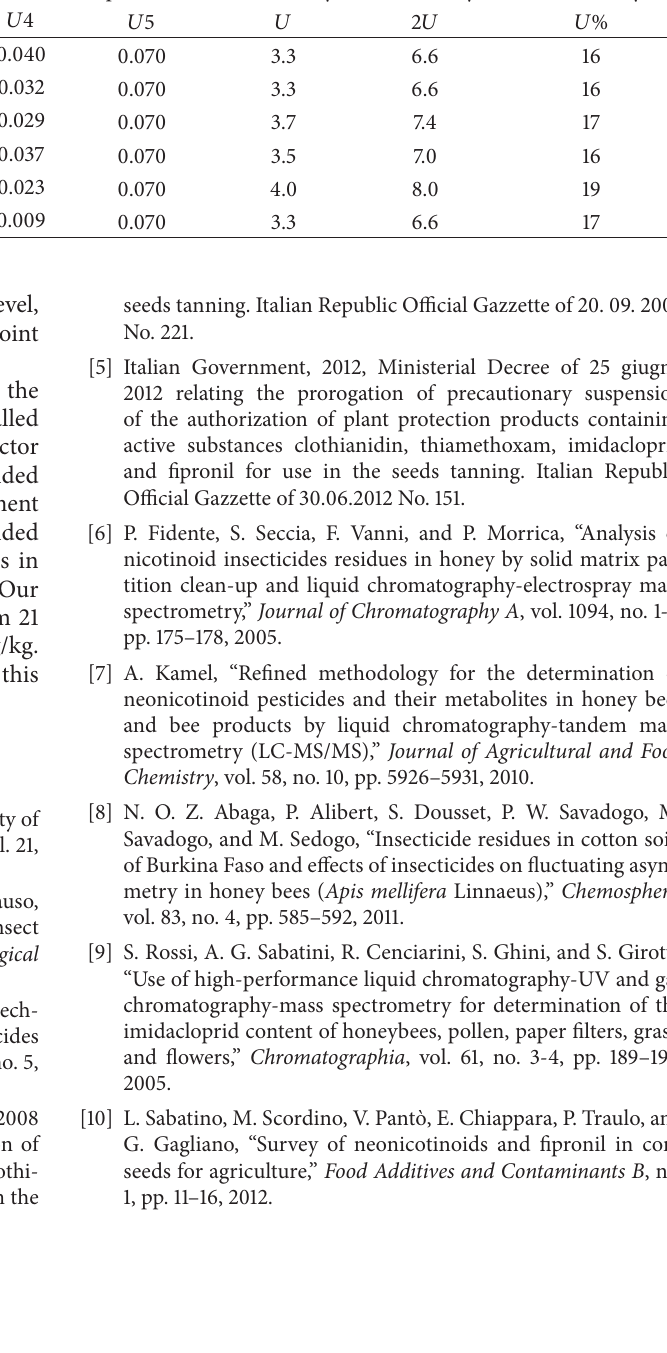
Table 4: Results of individual and combined uncertainties for each pesticide calculated at 40 𝜇 g/kg concentration level.